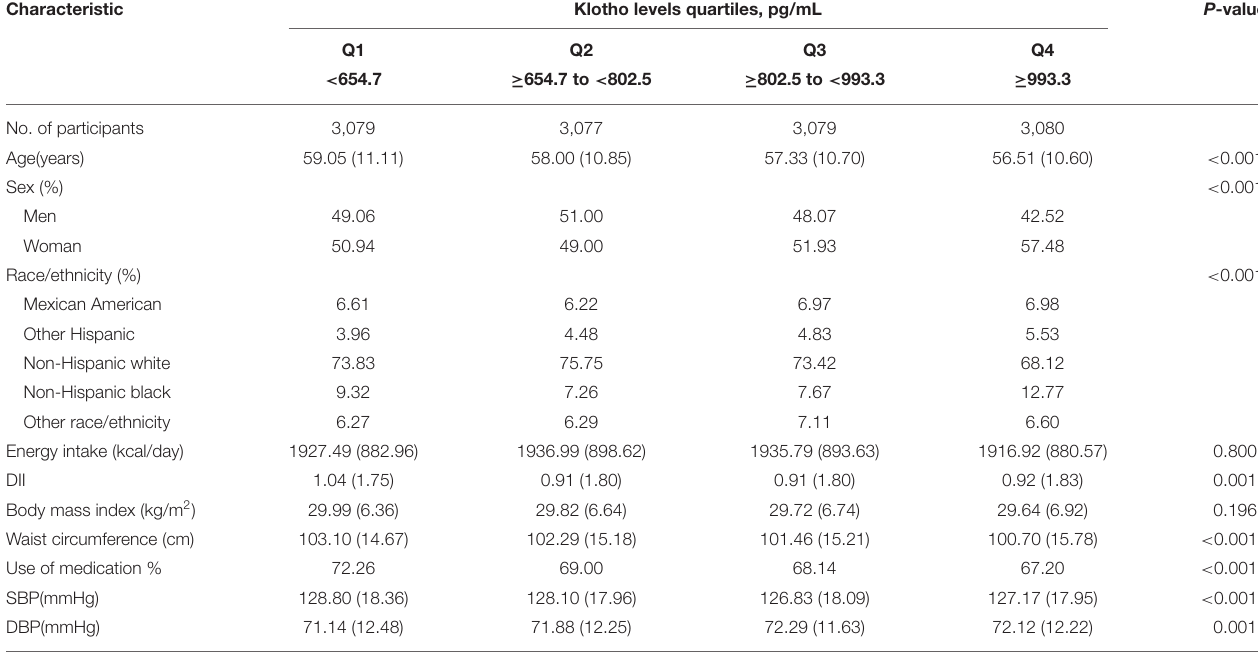
TABLE 1 | Baseline characteristics of participants ( N = 12,315). Characteristic Klotho levels quartiles,